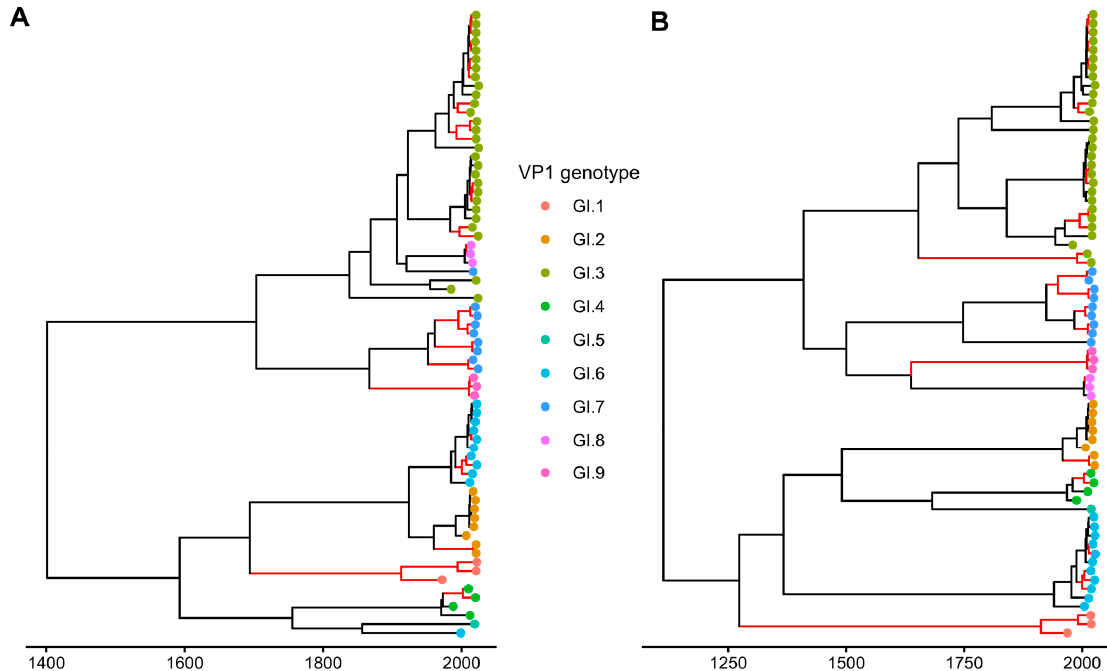
Figure 6. MCC trees of RdRp ( A ) and VP1 ( B ) genes of GI noroviruses. The scale bar represents time in years. Branches leading to matching subtrees in both trees are colored red. Since all branches in both trees had posterior probabilities above 0.92, branch support is not indicated on the figure. The tree branches are colored according to the VP1 genotype.